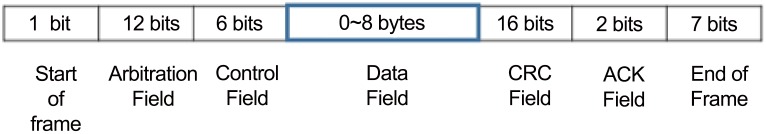
CAN packet syntax.